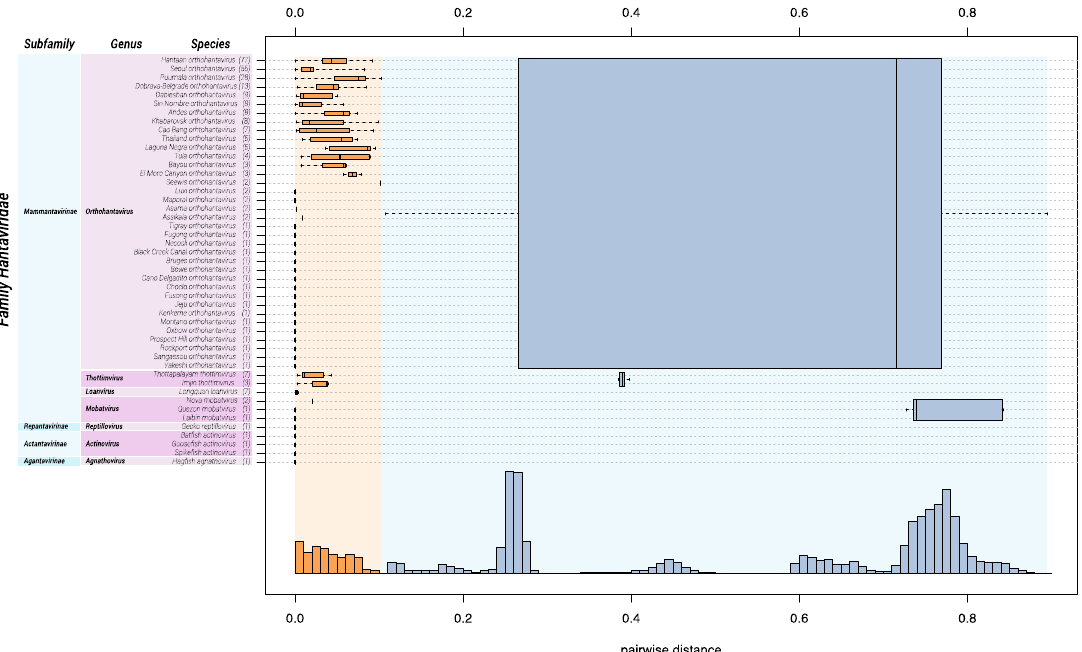
Figure 1. DEmARC analysis of the family Hantaviridae . Bayesian phylogenetic inference of hantavirid species is shown on the left. Hantavirids are classified into subfamilies, genera, and species based on DEmARC analysis (right). A frequency distribution ( y -axis) of the PED values ( x -axis) was plotted by species (orange), genus (blue), and subfamily (purple) demarcation. Boxplots and whiskers plot rank-specific PED distributions.